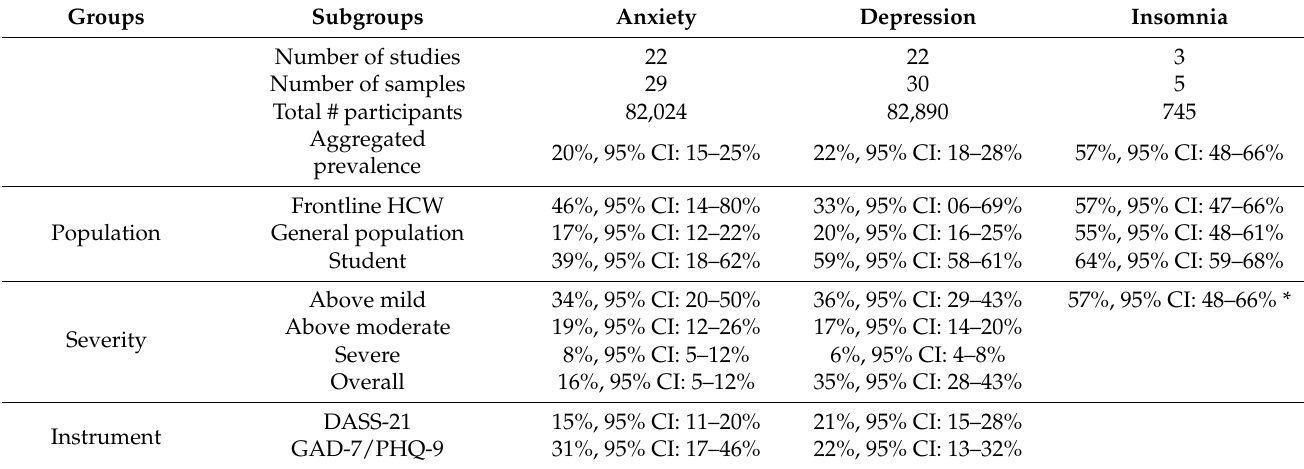
Table 3. Subgroup analyses of the prevalence of anxiety, depression, and